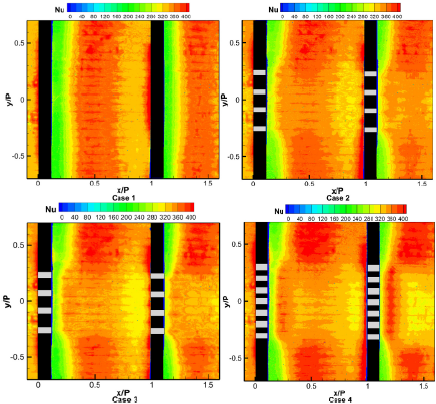
Figure 5. Local Nusselt number contours for perforated rib turbulators [55]. Figure reprinted from an open source. an open